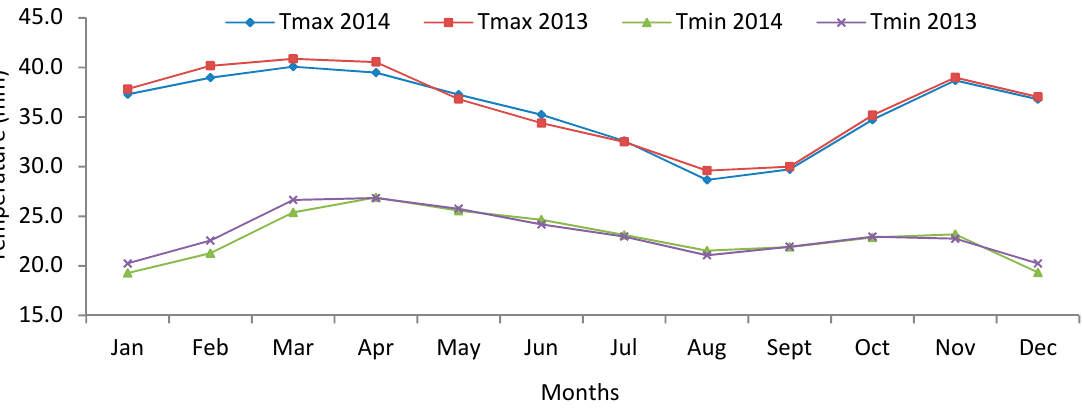
Figure 2. Average seasonal air temperatures (maximum and minimum) in 2013 and 2014 at Youé research farms in Chad.